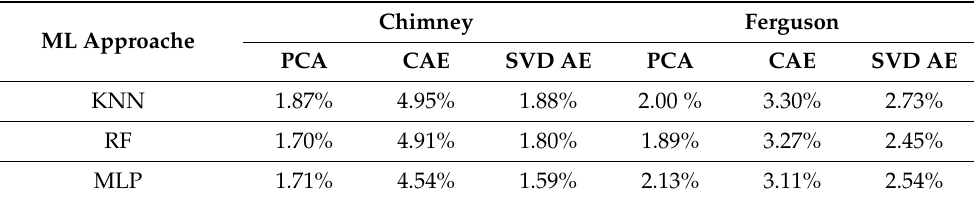
Table 4. Averaged prediction error for Chimney and Ferguson fires at day 4 in the full physical space after decoding. The dimension of the latent space is fixed as q = 30. Chimney